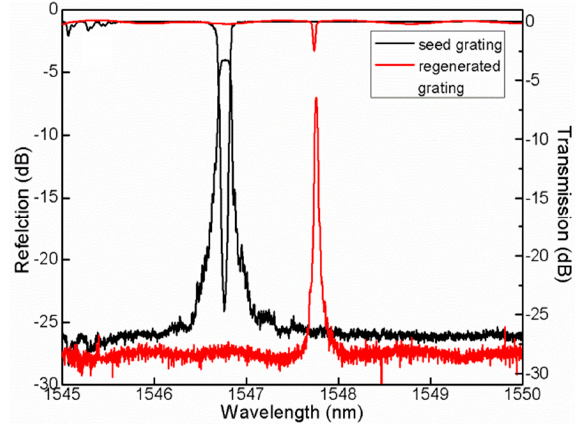
Figure 7. Reflection and transmission spectra of seed gratings (black curve) and regenerated fiber Bragg gratings (red curve).